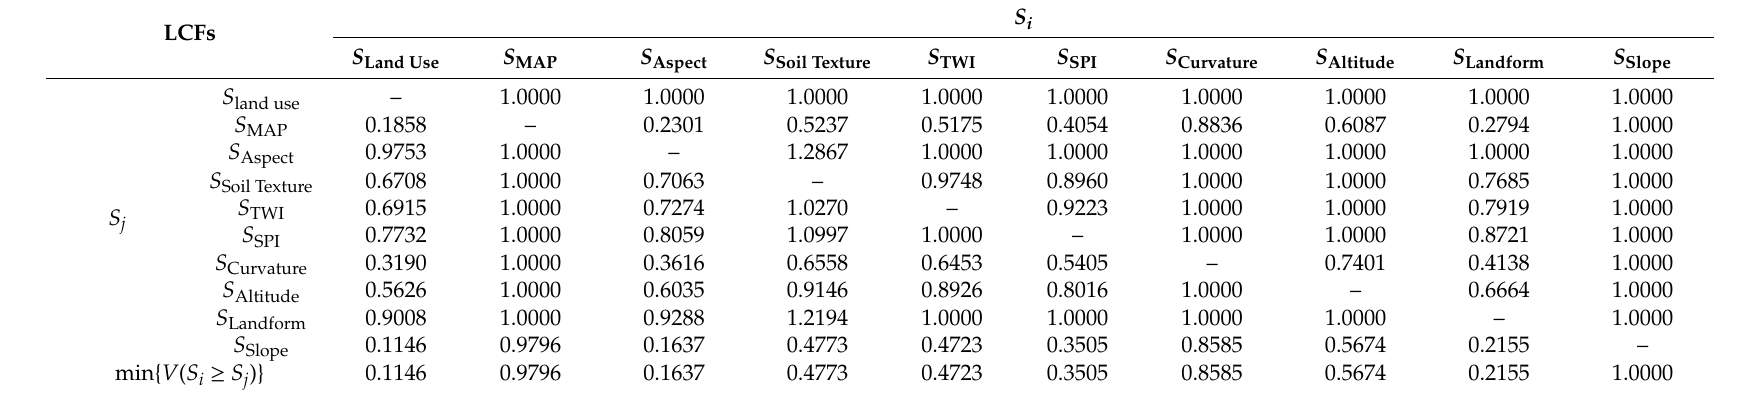
Table 5. The calculation of degree possibility for Si ≥ Sj and weight of